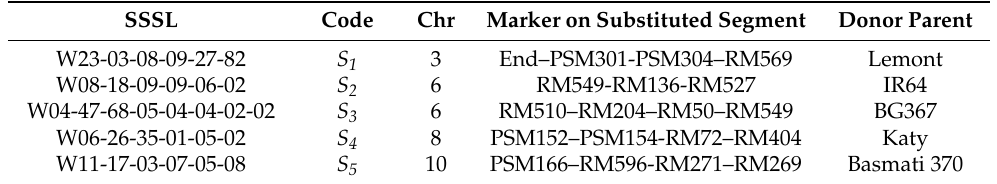
Table 1. Single-segment substitution lines (SSSLs) and their basic information. SSSL is an abbreviation of single-segment substitution line. S i represents the code of the i th SSSL. Chr is an abbreviation of